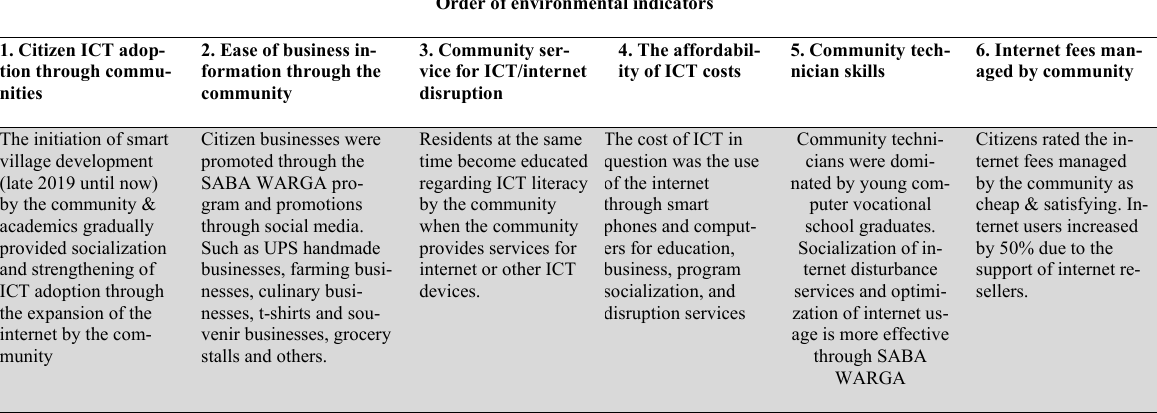
Analysis of the contribution level of environment by empowerment variables to the smart economy Order of environmental